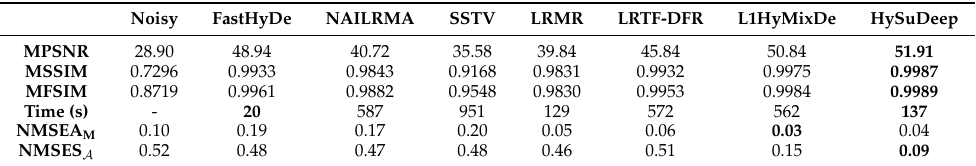
Table 3. Denoising performance of the proposed and comparison methods on the Terrain image and unmixing performance (in terms of NMSEA M and NMSES A ) of “VCA + FCLS” applied to the denoised